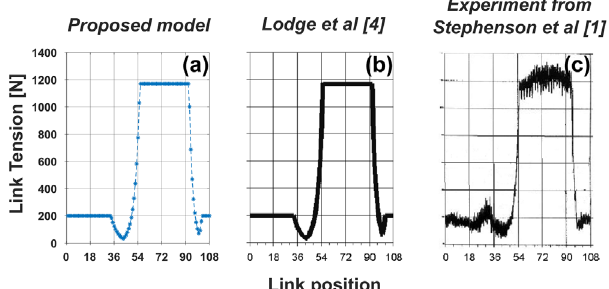
Fig. 14. Theorical and experimental link tension for a torque of 53